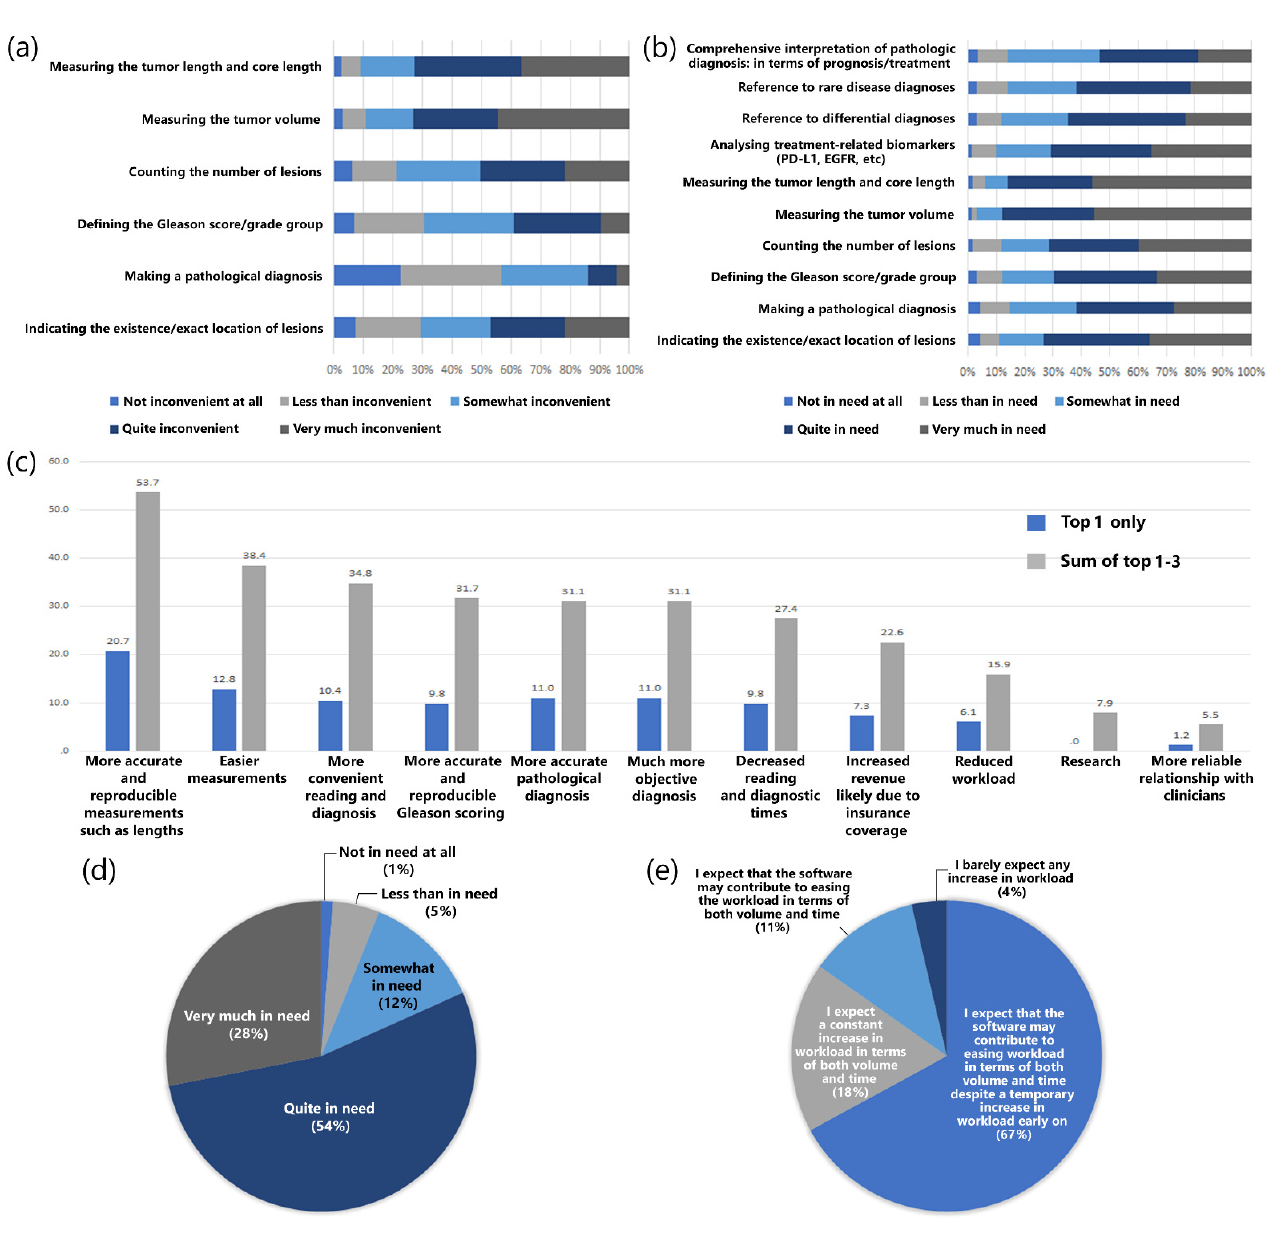
Figure 3. Expectations and concerns with computer-aided diagnosis (CAD) software for a prostate needle biopsy. ( a ) The degree of discomfort by readout items of a prostate needle biopsy. When diagnosing prostate needle biopsy specimens, pathologists responded that ‘measuring the tumor volume’ and ‘measuring the tumor length and core length’ were the most inconvenient aspects. ( b ) Required capabilities for prostate needle biopsy CAD software. In prostate needle biopsy CAD software, pathologists responded that the function of ‘measuring the tumor length and core length’ was